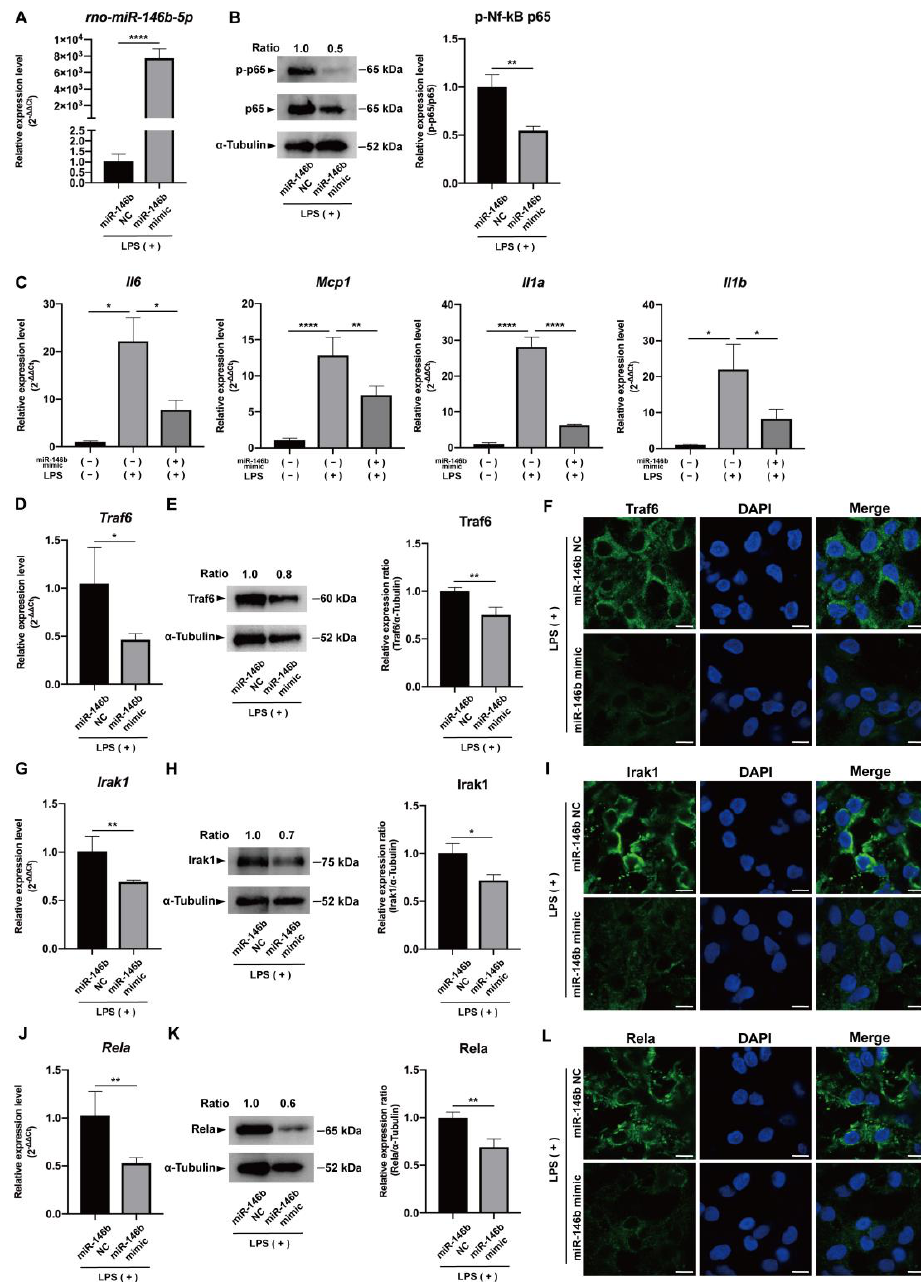
Figure 6. rno-miR-146b-5p mimic down-regulates mRNA expression of pro-inflammatory mediators in LPS-stimulated ex vivo cultured rat incisor pulp tissue. ( A ) Transfection of rno-miR-146b-5p mimic induced significant up-regulation of rno-miR-146b-5p in LPS-stimulated ex vivo cultured rat incisor pulp tissue (mean ± SD, n = 3). ( B ) rno-miR-146b-5p mimic significantly down-regulated the phosphorylation of NF-κB p65 in ex vivo cultured rat incisor pulp tissue with 6 h LPS stimulation (mean ± SD, n = 3). ( C ) rno-miR-146b-5p mimic significantly down-regulated the promoted mRNA expression of pro-inflammatory cytokines Il6 , Mcp1 , Il1a , and Il1b in ex vivo cultured rat incisor pulp tissue with 6 h LPS stimulation (mean ± SD, n = 3). ( D , G , J ) mRNA expression and ( E , F , H , I , K , L ) protein expression of Traf6, Irak1, and Rela were drastically down-regulated by over-expression of rno-miR-146b-5p in rat incisor pulp tissue 6 h after LPS stimulation (mean ± SD, n = 3). * p < 0.05, ** p < 0.01, and **** p < 0.0001. LPS: lipopolysaccharide; miR-146b NC: miRNA mimic Negative Control #1; miR-146b mimic: miRNA mimic for rno-miR-146b-5p; Scale bars: 5 µ